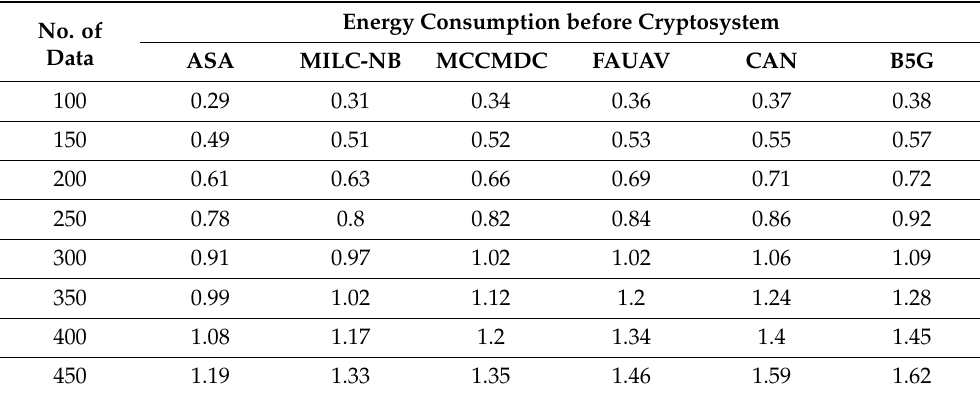
Table 5. Analysis of Energy Consumption before Cryptosystem